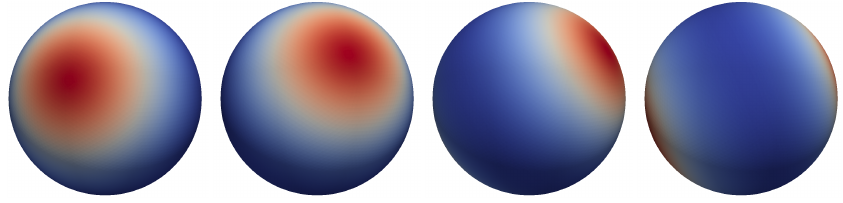
Fig. 11. Snapshots of the solution to the transport equation obtained using the method of Sect. 5.4.